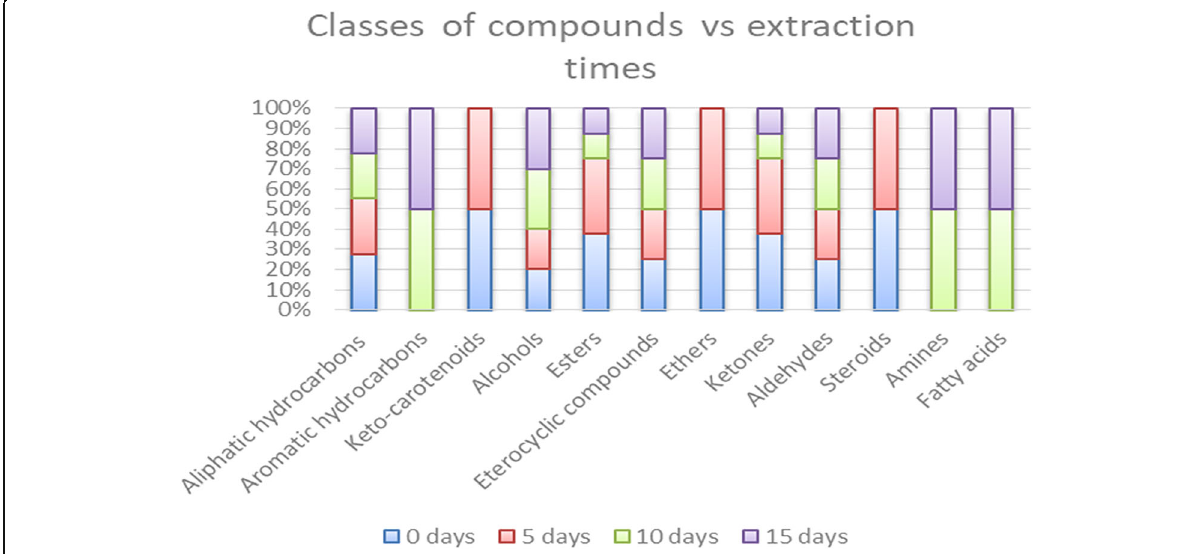
Fig. 4 Distribution of the classes of compounds at the different analysis